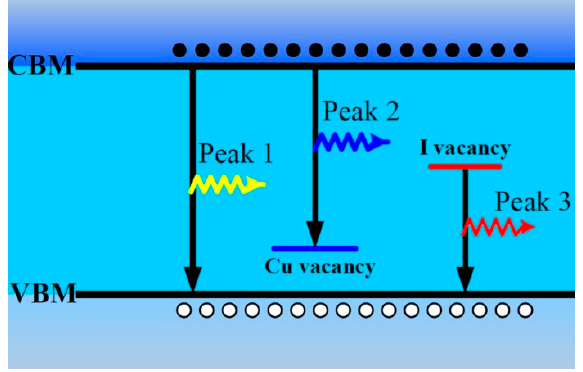
Figure 6. Proposed mechanisms of PL in CuI thin films.